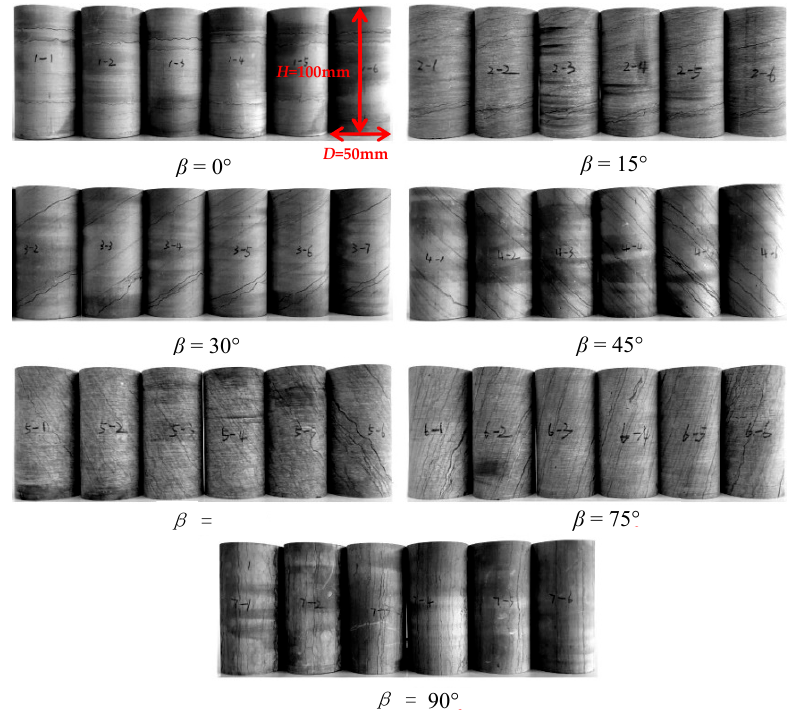
Figure 7. Rock specimens with different dip angles, β (modified after Huang et al. [41]).